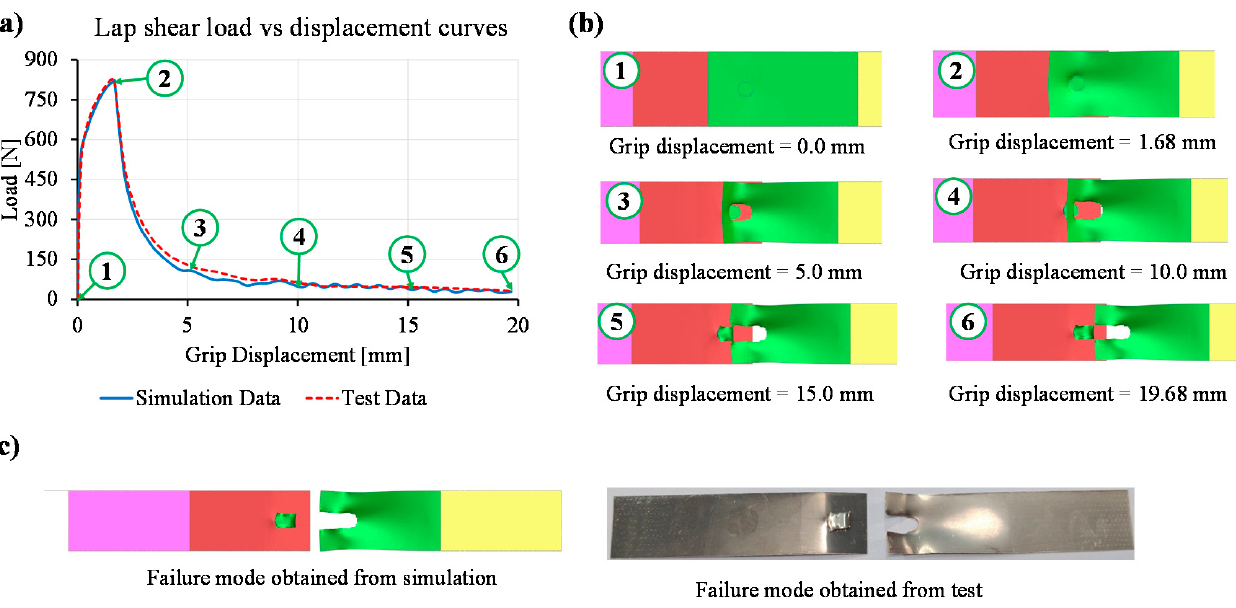
Figure 10. Simulation of lap shear test considering 5 mm diameter circular seam: ( a ) comparison of load–displacement curves obtained from simulation and tensile tests, ( b ) sequence of images from the simulation at specific grip displacement, and ( c ) failure modes obtained from simulation and test.